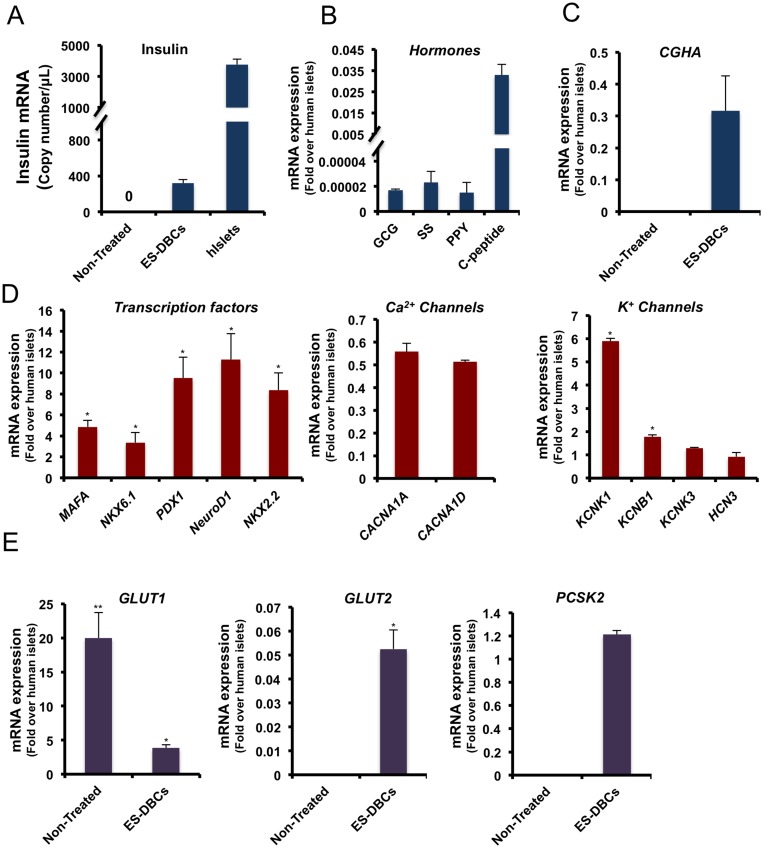
The mRNA expression analysis of pancreatic islet, beta-cell and related genes in the differentiated human H1 ES-DBCs.(A) Exact copy number of insulin mRNA molecules in the ES-DBCs and human islets by digital droplet RT-PCR (GAPDH was used for normalization). Quantitative real time RT-PCR analysis for (B) endocrine hormones, (C) Chromogranin A, (D) pancreatic transcription factors, Ca+2 and K+ channels genes, (E) Glucose transporters (GLUT1 and 2) and PCSK2 as the enzyme required for pro-insulin processing and in the ES-DBCs compared to human islets. (*p< 0.05, **p< 0.01, p***<0.001, unpaired two-tailed t-test, n = 3).